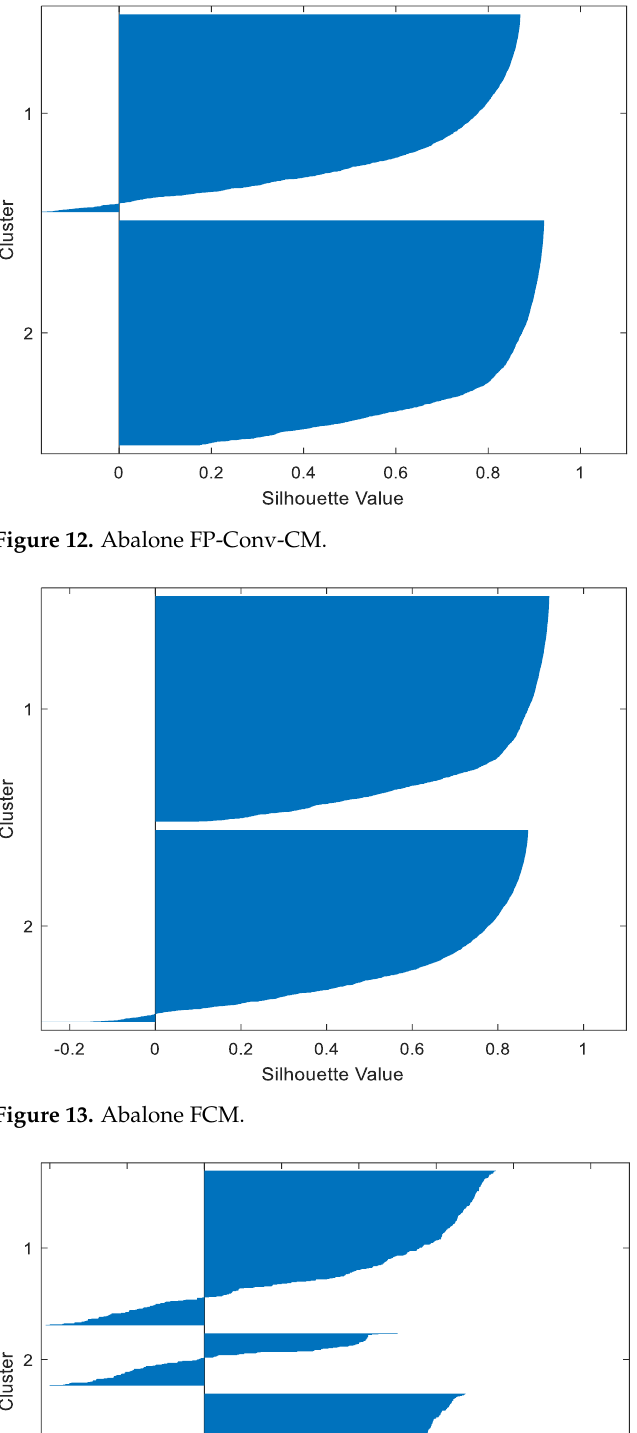
Figure 11. Foods GMM.